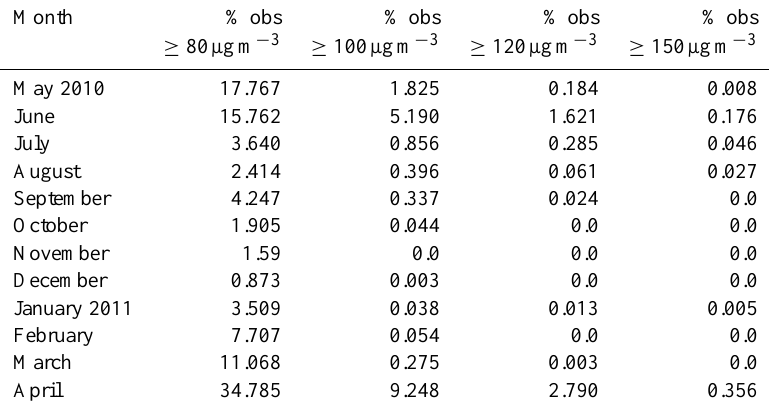
Table 1. Prevalence of ozone episode conditions by month between 1 May 2010 and 30 April 2011. For each month, the percentage of hourly average observations (across all sites) where the ozone concentration exceeds the given threshold is